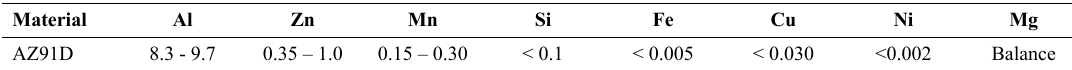
Table 1. Nominal Chemical composition of the AZ91D alloy